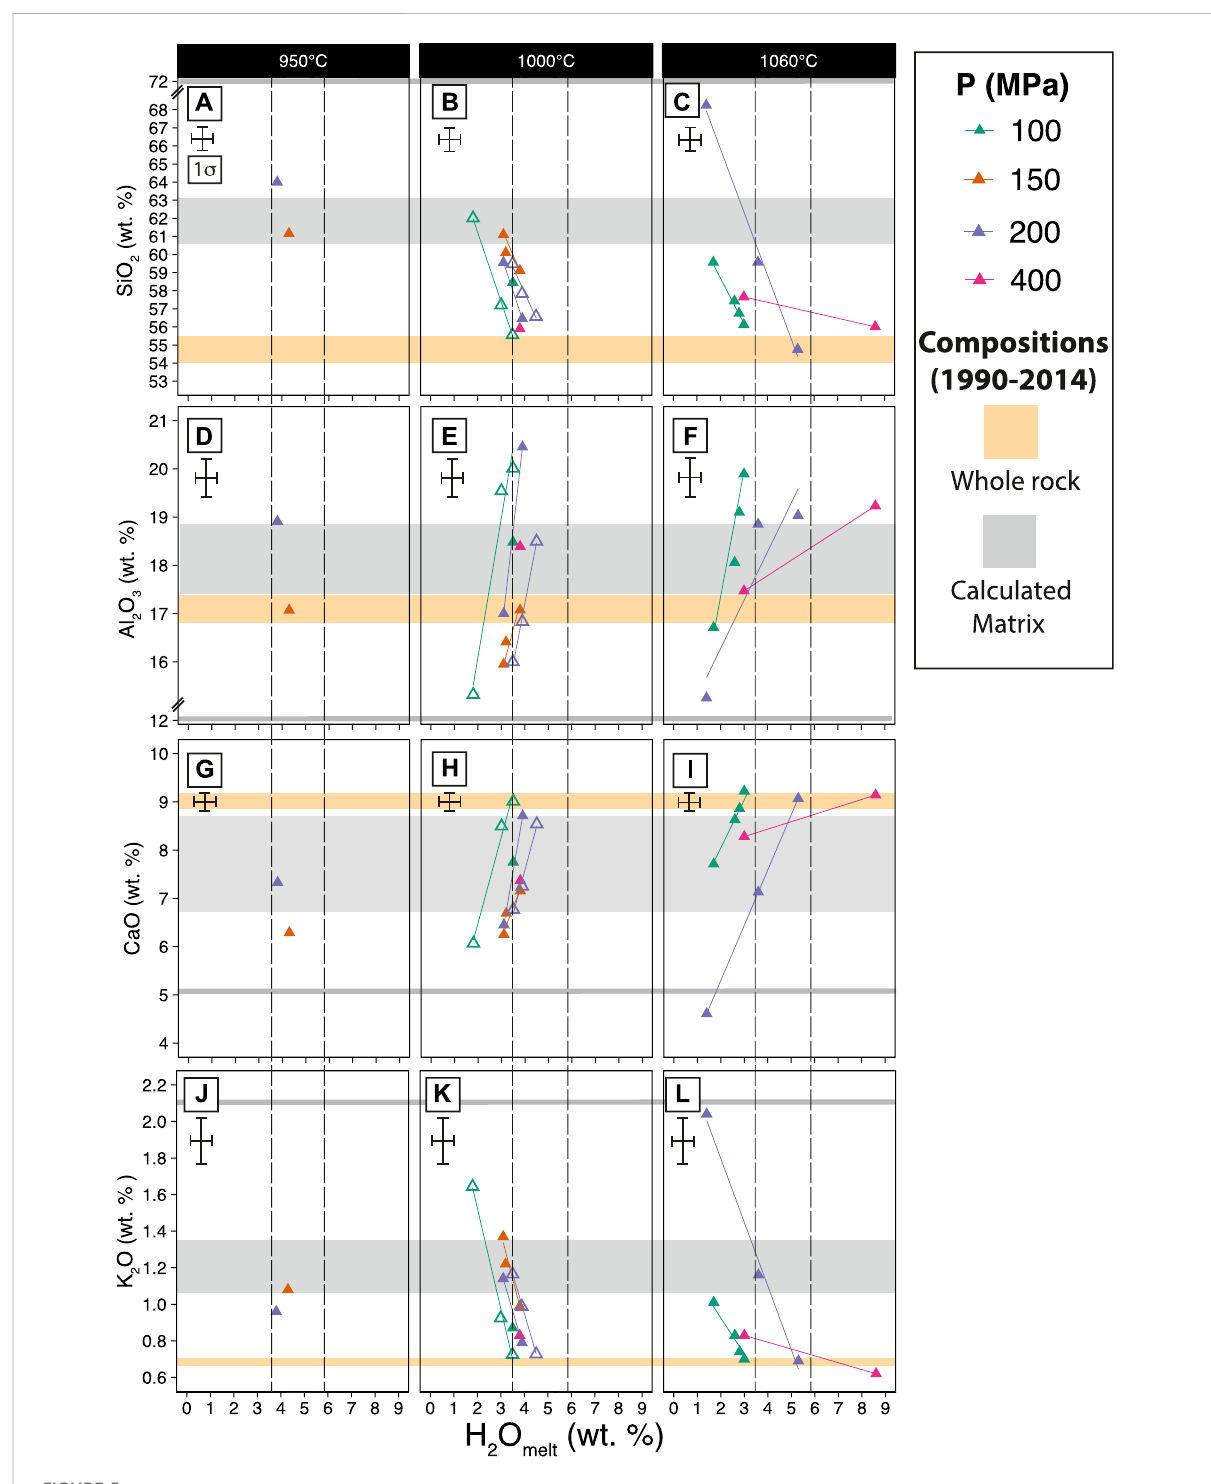
FIGURE 5 Major element oxide compositions of experimental glasses (in wt%) vs. dissolved water content in the melt according to three different temperatures SiO calculatedmatrixfortheexplosiveeruptions(1990,2014);thethingraybandisthecalculatedmatrixofthe2007dome(Table1).Thecalculated matrix compositions for the 1990, 2007, and 2014 eruptions were estimated by mass balance calculations (Albarede, 1995) (see Methodology section). Vertical dashed lines are water content in the melt inferred from crystallinity and phase assemblage (Figures 3, 4). Filled symbols represent experiments at NNO; open lined symbols represent experiments at NNO